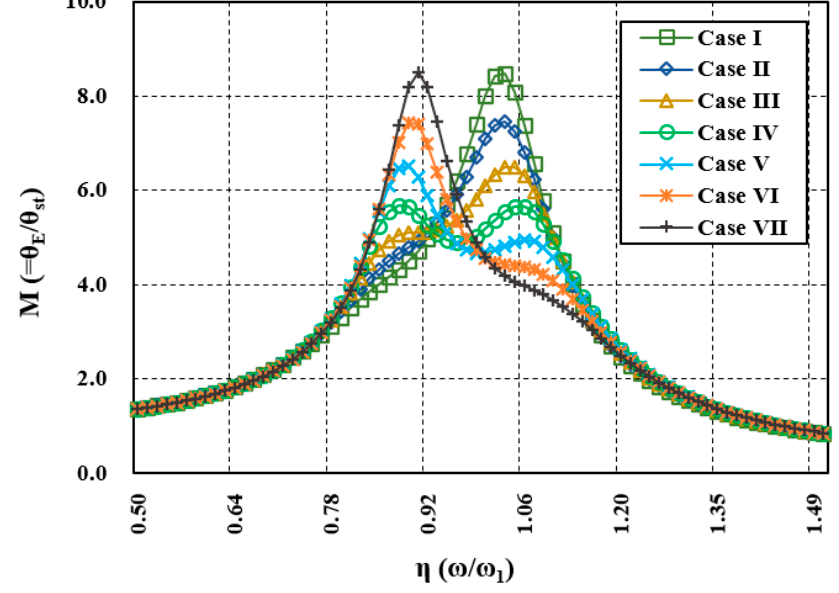
Figure 7. Vibration characteristics of the viscous-spring damper according to varied stiffness and damping coefficient ratio.